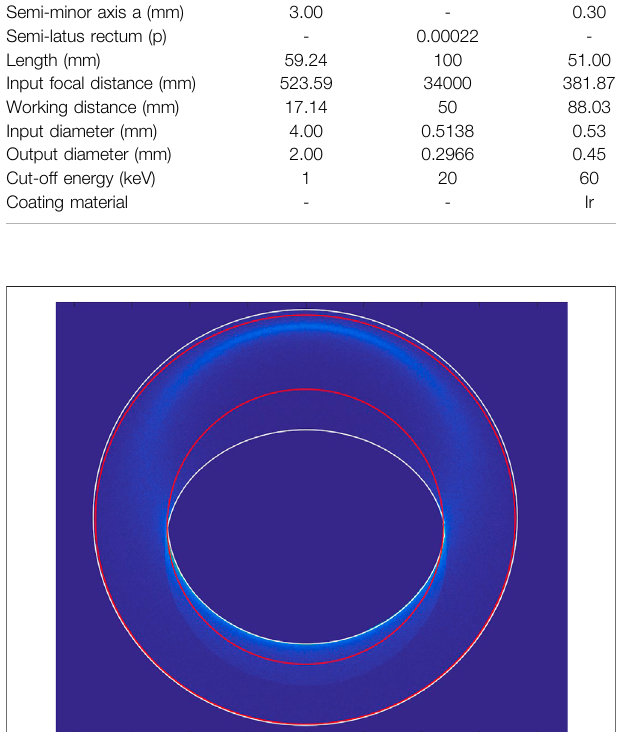
FIGURE7| Simulated far- fi eld image of the ellipsoid capillary El 1 . The two red circles represent the inner and outer boundaries of the ideal focusing ring. The two white irregular circles represent the inner and outer boundaries of the ideal focusing ring with the centerline and the surface shape errors.